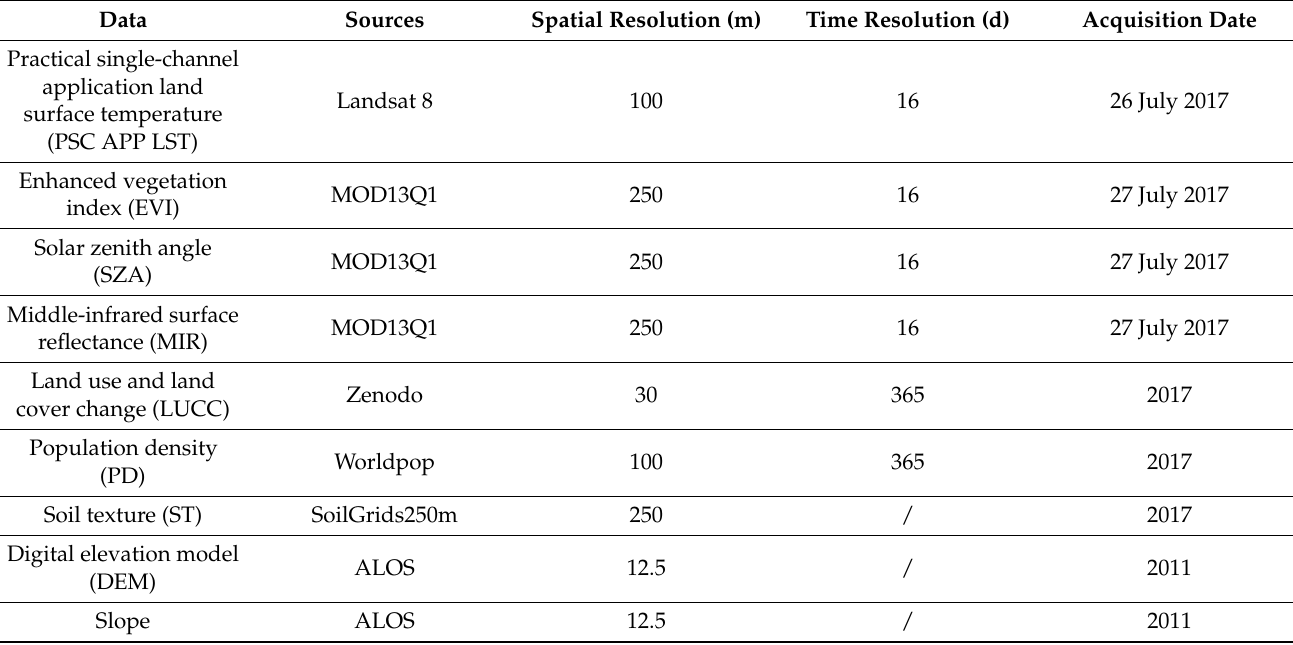
Table 1. The sources of LST data and the related spatial